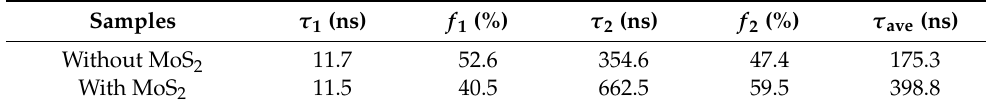
Table 1. Relevant parameters fitted using the TRPL